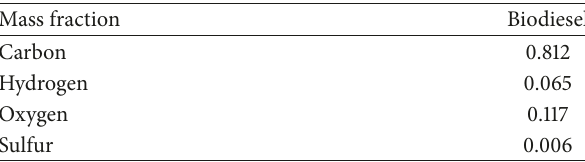
Table 2: Composition of biodiesel from WCO.